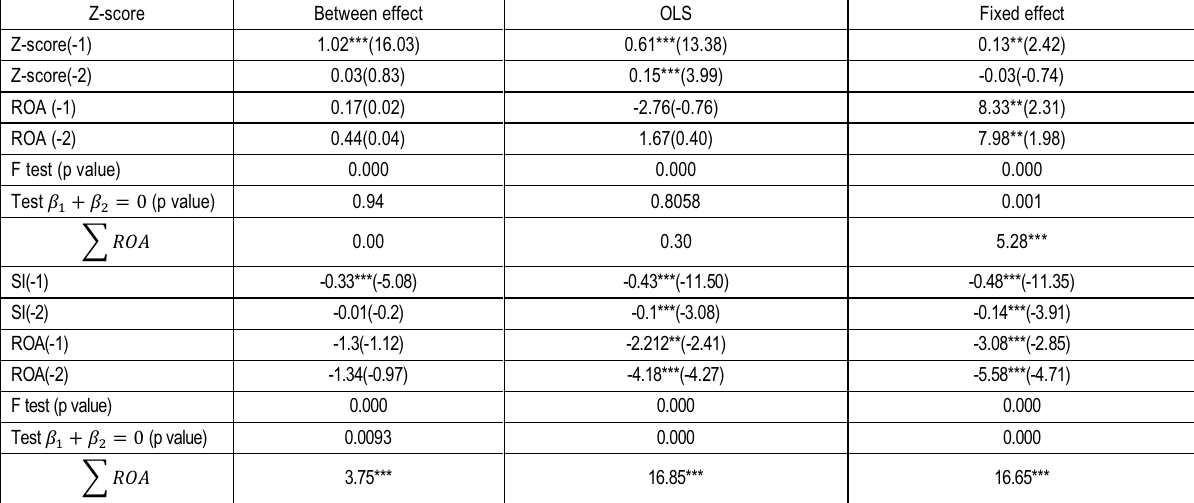
Table 7 Robustness test: the impact of profitability on insolvency